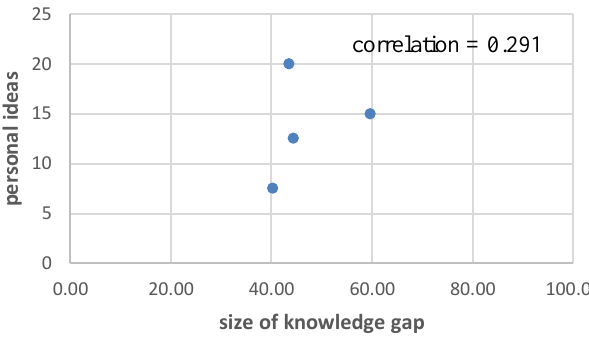
Fig.2. Using the agreement on the knowledge gap as a measure of the size of the knowledge gap, it is plotted against the number of individual ideas averaged per team. Each dot is a single team.